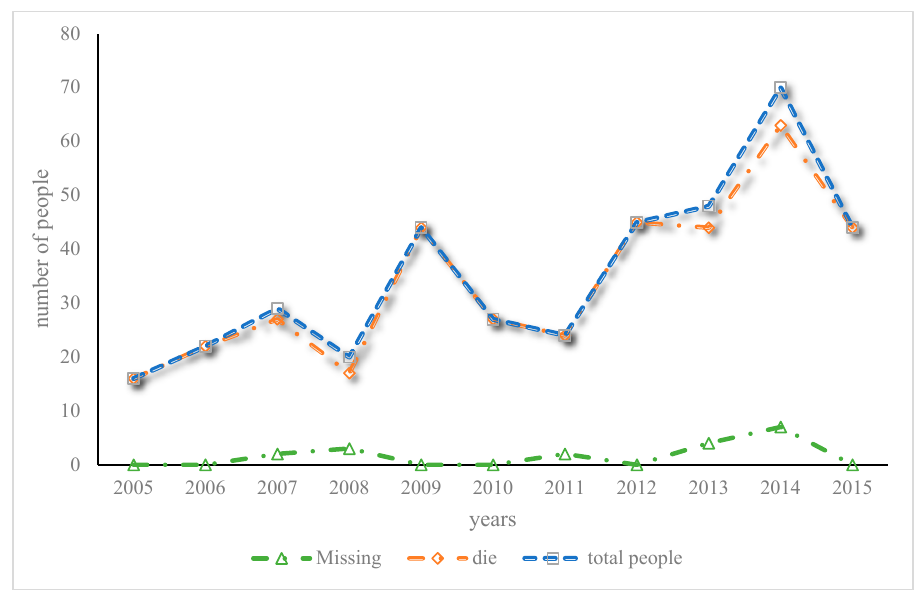
Figure 2. Trends in the number of casualties in mountaineering and outdoor sports from 2005 to 2015.